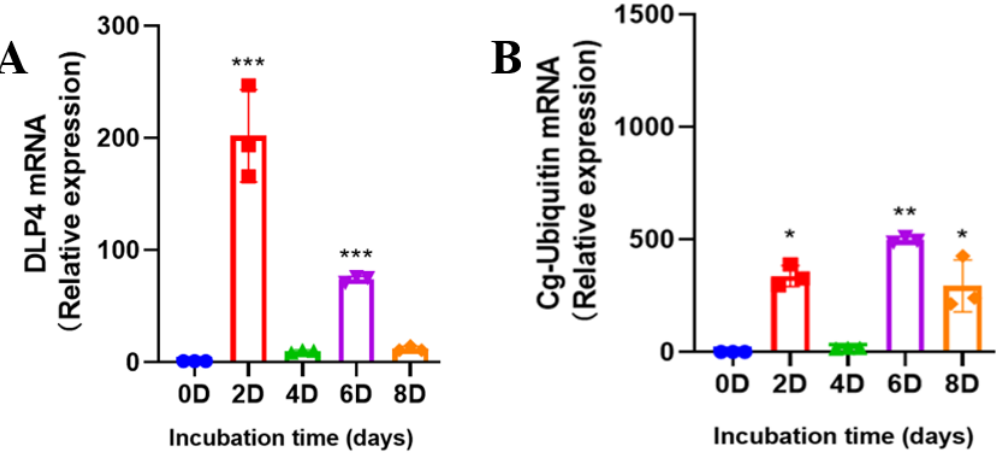
Figure 3. Quantitative real-time PCR analysis of DLP 4 and Cg-ubiquitin mRNA expression. ( A ) Temporal expression of the DLP4 transcripts in the larvae of BSF collected from the PM at different time points (zero, two, four, six, and eight days). ( B ) Temporal expression of Cg-Ubiquitin transcripts in the BSFL collected from PM at different time points (zero, two, four, six, and eight days). Statistical analyses were performed using ANOVA (* p < 0.05, ** p < 0.01, *** p < 0.001), and the data were analyzed compared with those on day 0.